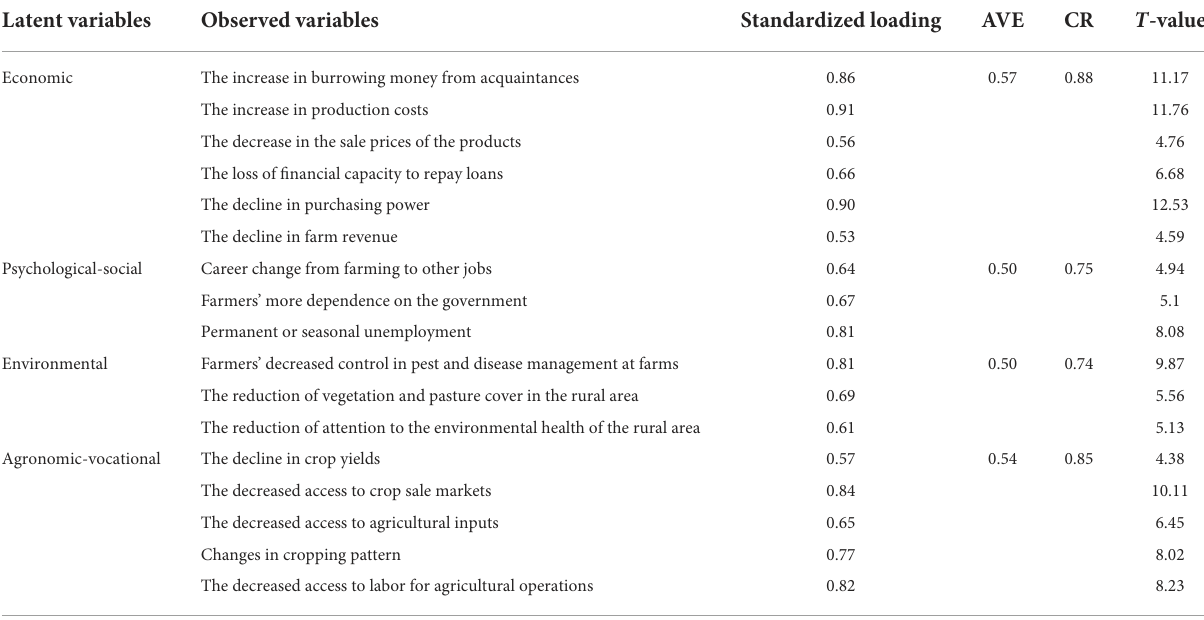
TABLE 7 The measurement coefficients, significance levels of the confirmatory factor analysis, and the validity and reliability of the variables. Latent